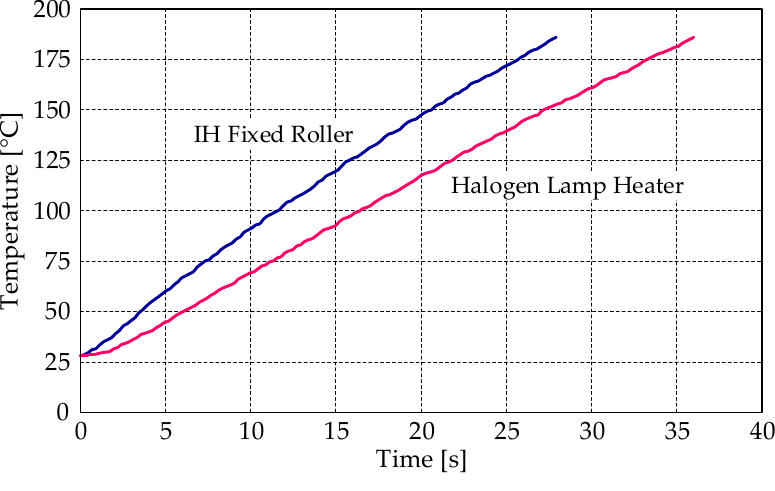
Figure 12. Temperature rise characteristics.